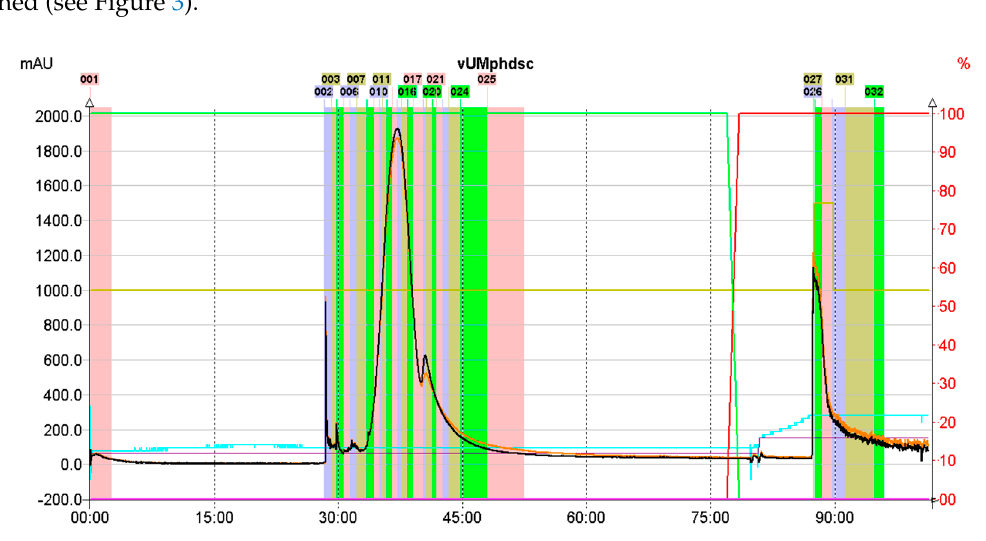
Figure 3. CPC chromatogram obtained from the separation of methanolic extract from Cretan barberry with a prominent magnoflorine peak in the 35th minute (above).